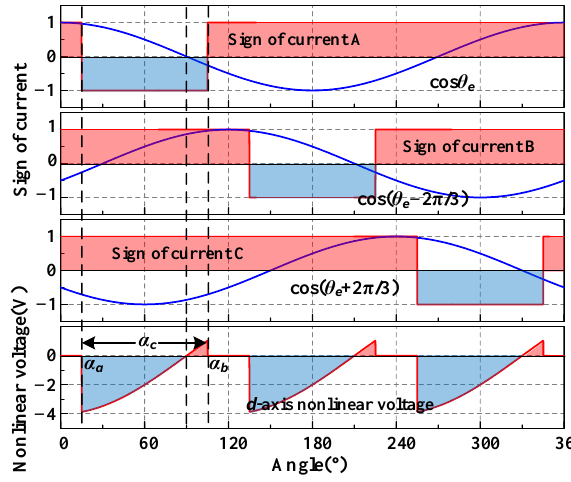
Figure 4. Diagram of d -axis nonlinear voltage.